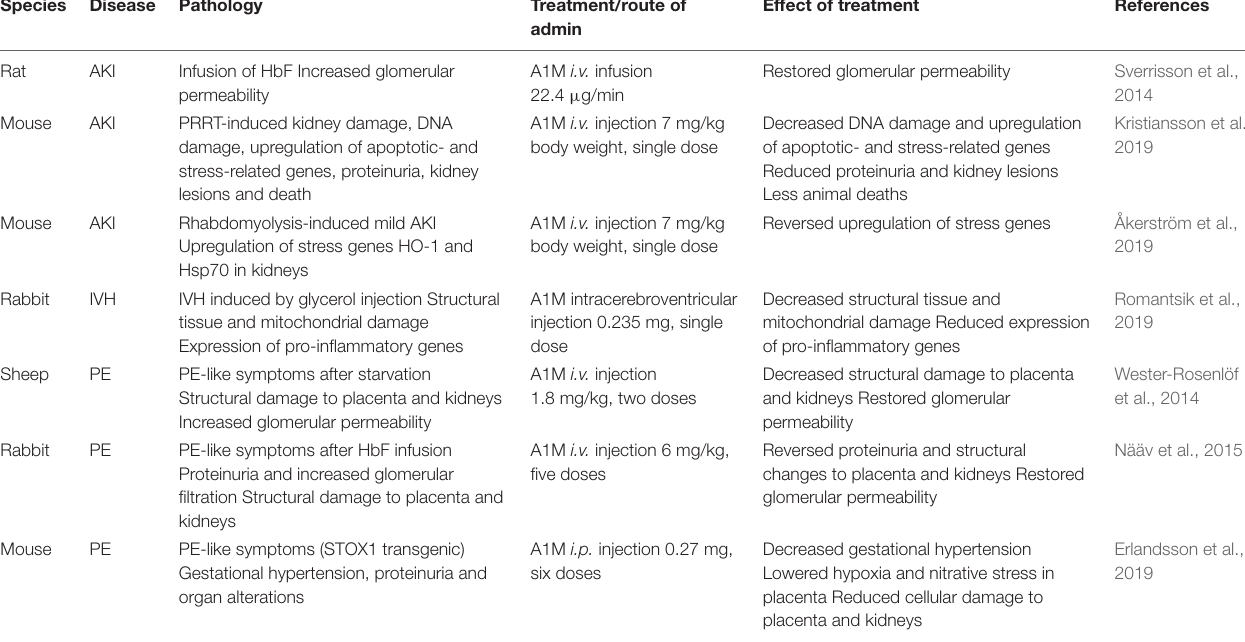
TABLE 1 | Summary of animal studies performed to examine the therapeutic potential of A1M against oxidative stress related